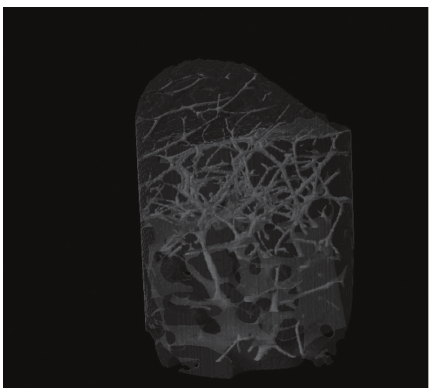
Figure 6: The micro-CT image of the cylinder-shaped bone